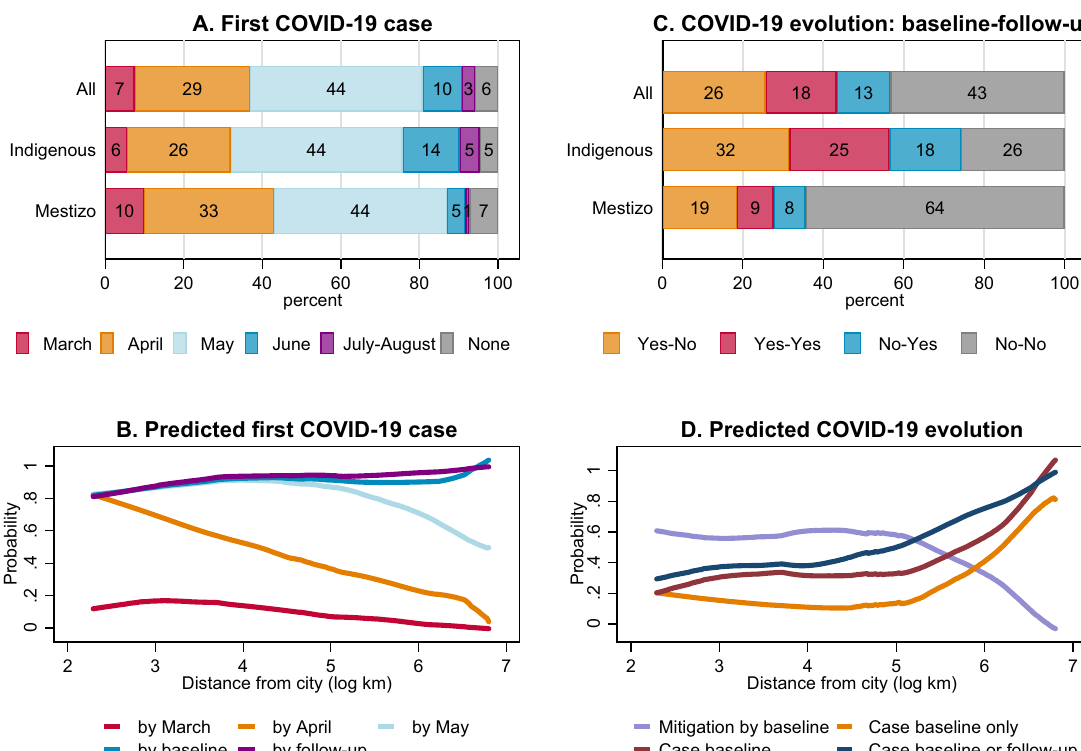
Figure 2. COVID-19 spread and evolution. First COVID-19 case in 2020 by indigeneity ( A ), nonparametric relationship of first case with distance from city ( B ), COVID-19 evolution between the baseline survey (in July 2020) and the follow-up survey (in August 2020) by indigeneity (for example, Yes–No means any case at the baseline and no case at the follow-up) ( C ), and nonparametric relationship of COVID-19 evolution with distance from city ( D ). In A June includes two communities which experienced first case in July and July–August means first case occurred between the baseline and follow-up surveys. In B and D Lowess (locally weighted scatterplot smoothing) smoothers are shown; one community with log distance from city smaller than 2 km is dropped for (e.g., distance) by controlling for other factors that may be correlated with both. Our sensitivity analysis indicates that most regression estimates are robust to omitted variable bias (see Supplementary Note 2). Without road access in the study area, local residents rely solely on river transportation for travelling. The river network distance from cities (Iquitos or Pucallpa) varies markedly by community (Supplementary Fig. 3A; range: 3–898 km, mean: 261 km). The timing of initial spread across communities depended on their remoteness: the nonparametrically predicted probability of spread by April and May shows negative steep distance gradients (Fig. 2B). The regression estimates for the initial spread by April, May, and the baseline survey are consistent with these bivariate nonparametric relationships: a 100% increase in the distance from cities decreased the probability of spread by April, for example, by 0.16 (or 44% of the mean of the dependent variable); in contrast, distances from nearest market town, district capital, and nearest community were not significant predictors (Fig. 3A, Supplementary Fig. 4, Supplementary Table 1). Dendritic river network structure (captured by river order), trade network (with city markets), and the availability of health facility were not significant predictors either (Supplementary Table 1). These results indicate that the primary factor determining the speed of spread was distance from the source of the virus, i.e., cities. The spatial distribution of the timing of spread in each basin is consistent (Fig. 1A). As Indigenous communities tend to be located further from cities than mestizo communities (Supplementary Figs. 2, 5; mean: 353 km vs.147 km), it took longer for the virus to reach Indigenous communities (until May), but by the time of the baseline survey in July the difference between these two types of communities had vanished (Fig. 2A). Our regression results show that for a given distance from cities, there was no significant difference between Indigenous and mestizo communities (Fig. 3D), indicating that their difference in the timing of spread was due to their difference in remoteness, not indigeneity per se. This illustrates the importance of multivariate regression analysis relative to bivariate correlation analysis, which would suggest significant relationships between the timing of spread and indigeneity. A variety of watercraft—both private and public boats—navigate Amazonian rivers 35,36 (‘River transportation’ in Methods). Public river transportation is effectively the only way for local people to travel from remote com- munities to cities and was available for 80% of all communities (Indigenous and mestizo) before the pandemic (Supplementary Fig. 6A). The government imposed mobility restrictions to suppress COVID-19 contagion.